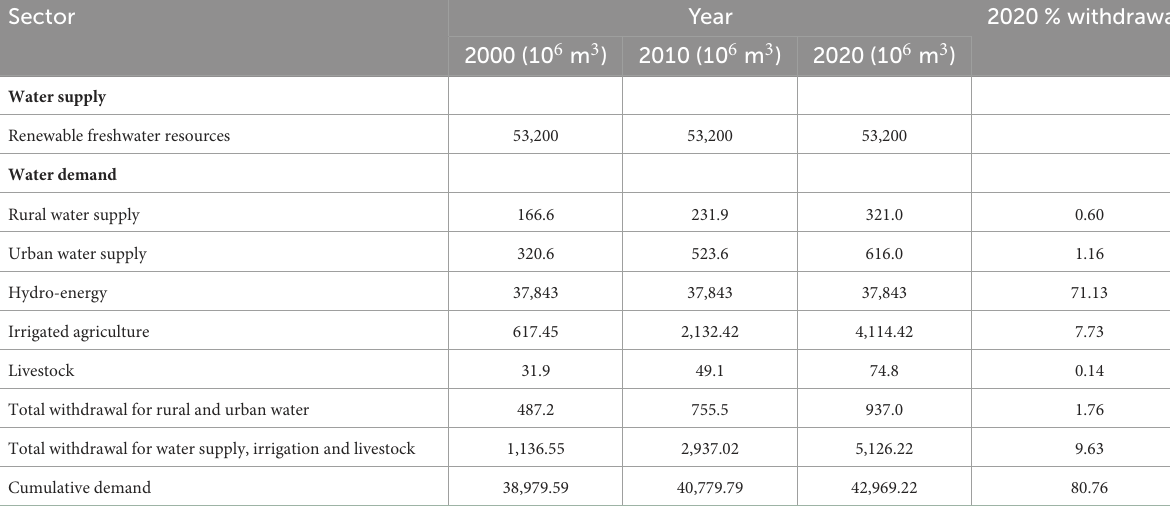
TABLE 4 Estimated consumptive and non-consumption use of freshwater resources from 2000 to 2020.